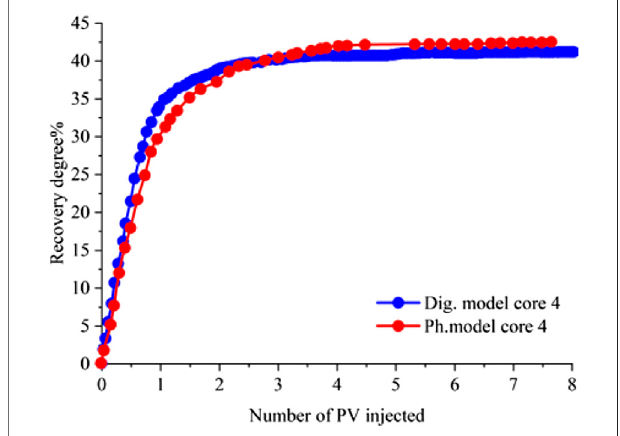
FIGURE 8 | Characteristics of physical model and digital model extraction